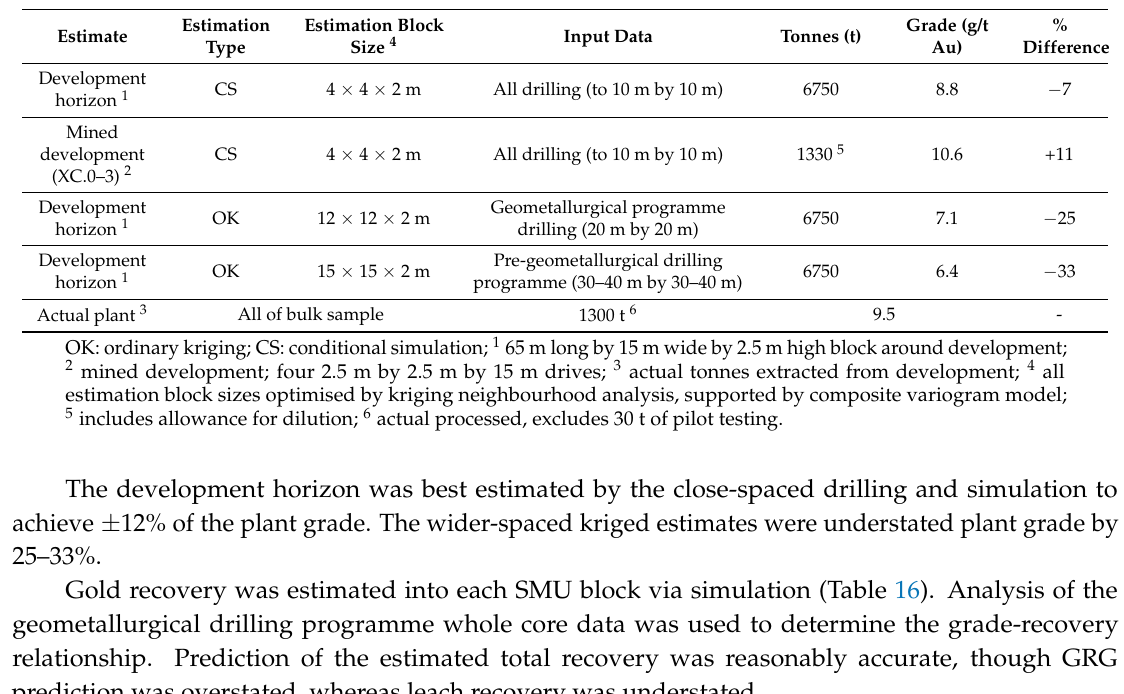
the SVZ. Bulk sample location and details given in Figure 2.